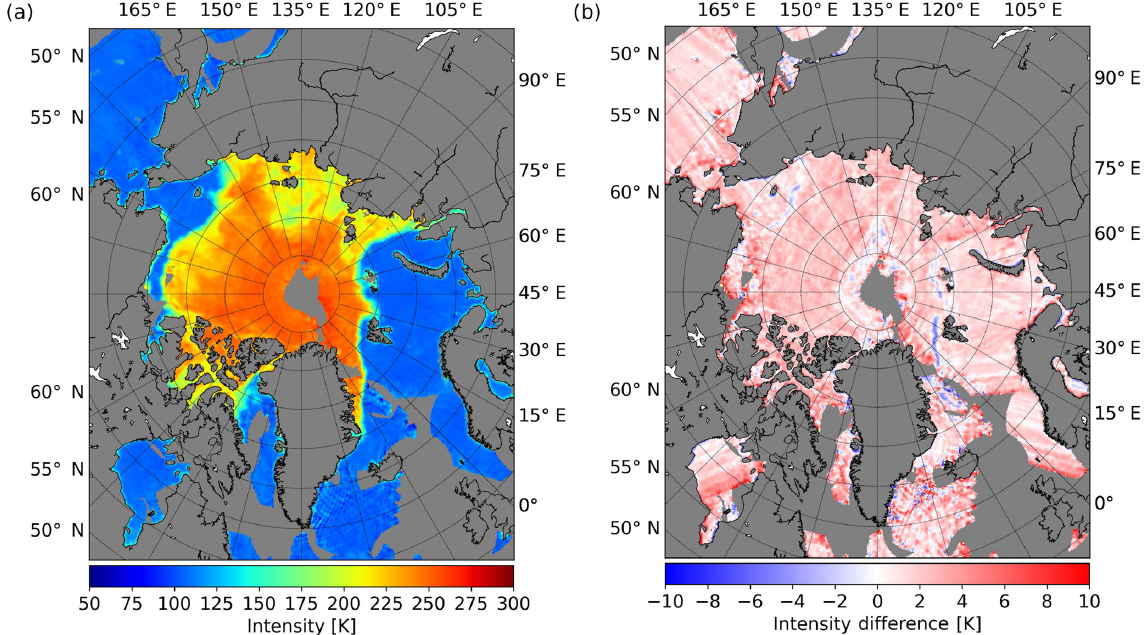
Figure 2. SMOS intensity for data version 6.20 data (a) for 29 October 2010 and intensity difference between the 6.20 and the 5.05 data versions (b)